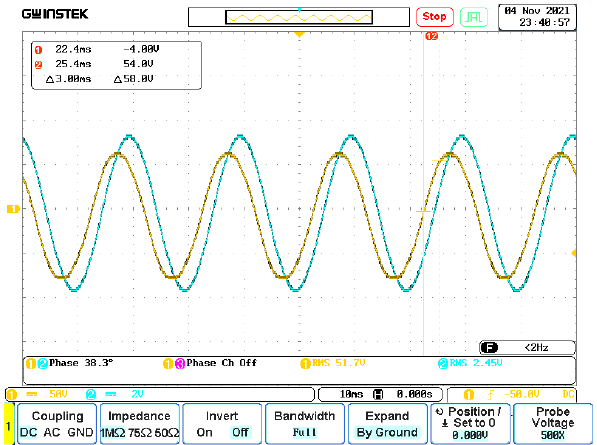
Figure 13. Experimental locked rotor test for winding 1 of the nine-phase IM including voltage (yellow line) and current (blue